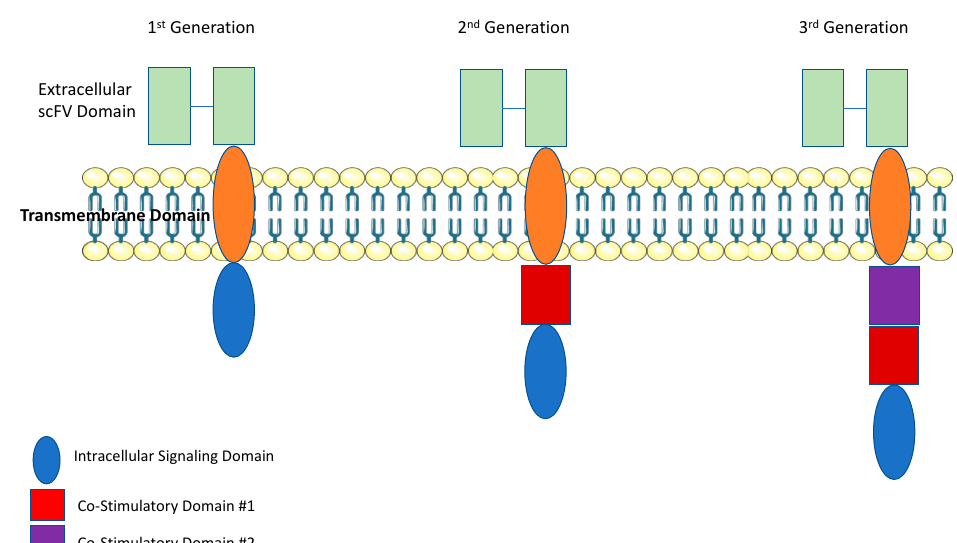
Figure 1. CAR T Cell Structure: CAR T cells are composed of 3 parts: (1) single-chain variable domain of an antibody (scFv), (2) a transmembrane domain, and (3) a signal transduction domain of the T-cell receptor (TCR). First-generation CAR T cells used a CD3 ζ as the signal transduction domain of the